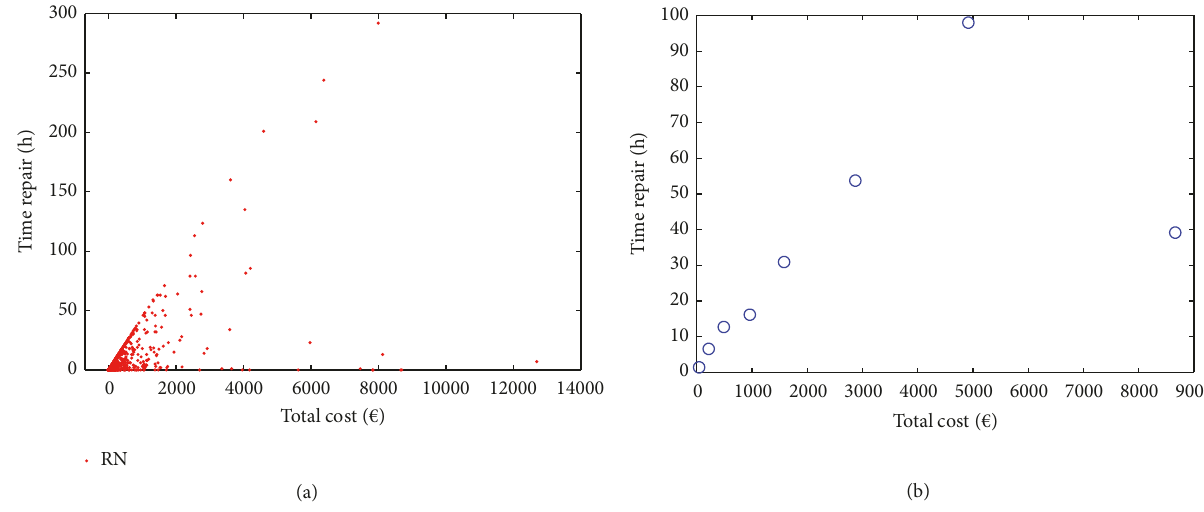
Figure 6: (a) Artificial Neural Network SOM trained; (b) SOM topology sample